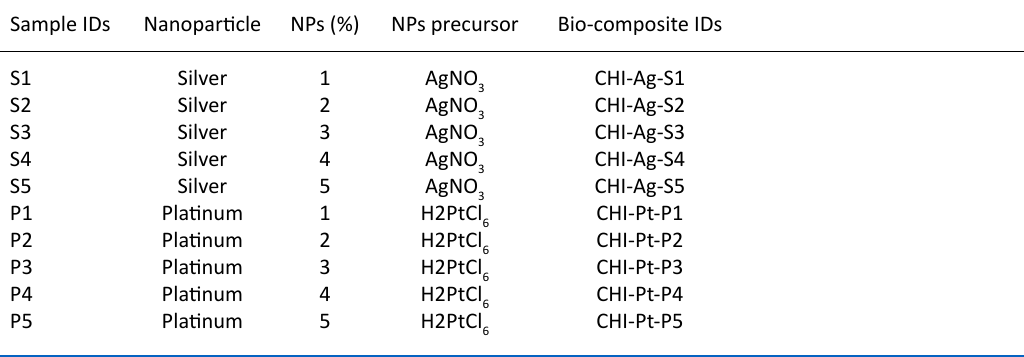
Table 2. Sample IDs of newly in-house engineered silver and platinum nanoparticles loaded chitosan-based bio- composites Sample